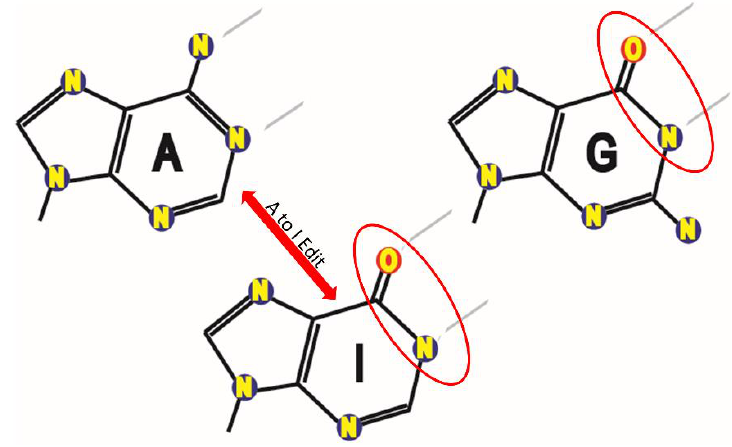
Figure 1. ADARs deaminate adenosine to inosine, potentially altering miRNA complementarities . A cartoon depicting adenosine ( left ), deaminated adenosine (inosine, in center ), and guanine ( right ).